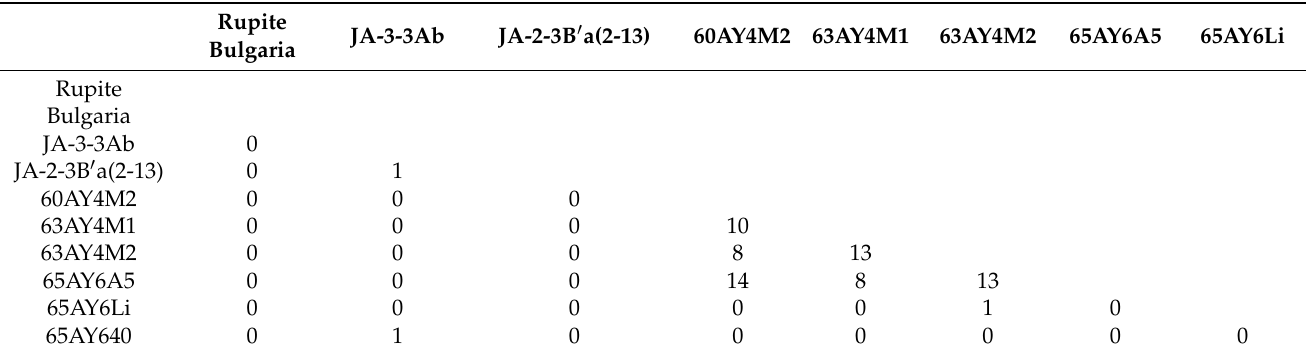
Table 2. The matrix of common identical spacers among the investigated strains.